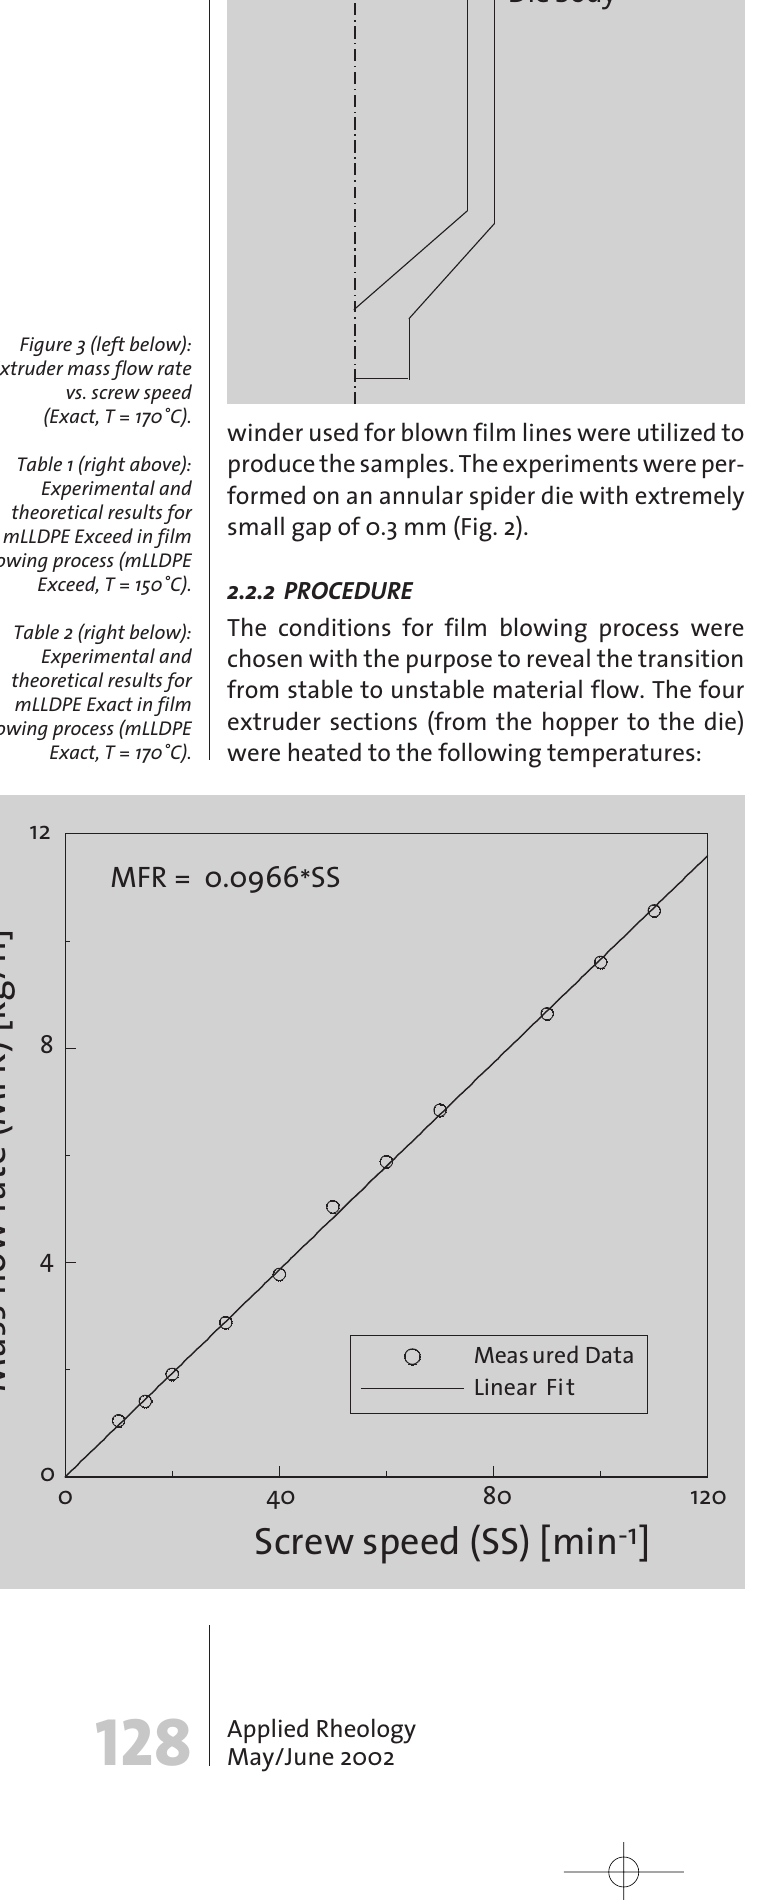
Die bodyMandrel